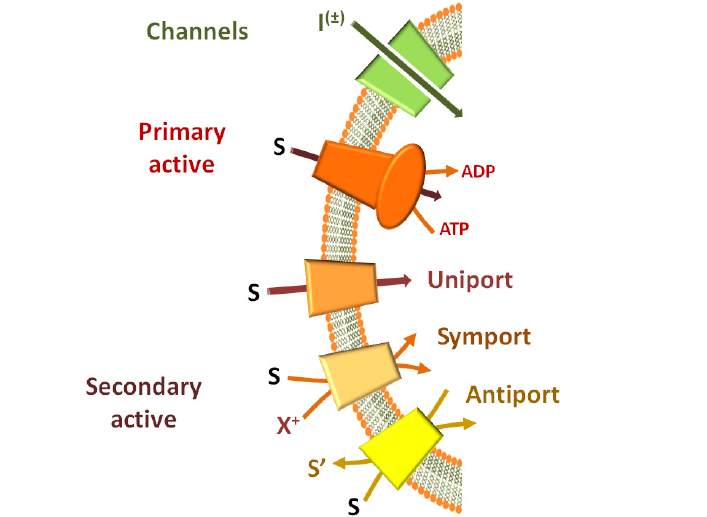
Figure 1. Functional classification of membrane proteins. Channels are depicted in green and I (±) represents the translocated ion. S represents the transported substrate in both primary and secondary active transporters. ATP hydrolysis for primary active transporters is highlighted. Transport mechanisms of secondary active transporters are described (uniport, symport and antiport). In the symport scheme, X + indicates a generic cation and its concentration difference drives the transport. In the antiport scheme, S’ indicates the countersubstrate driving the vectorial